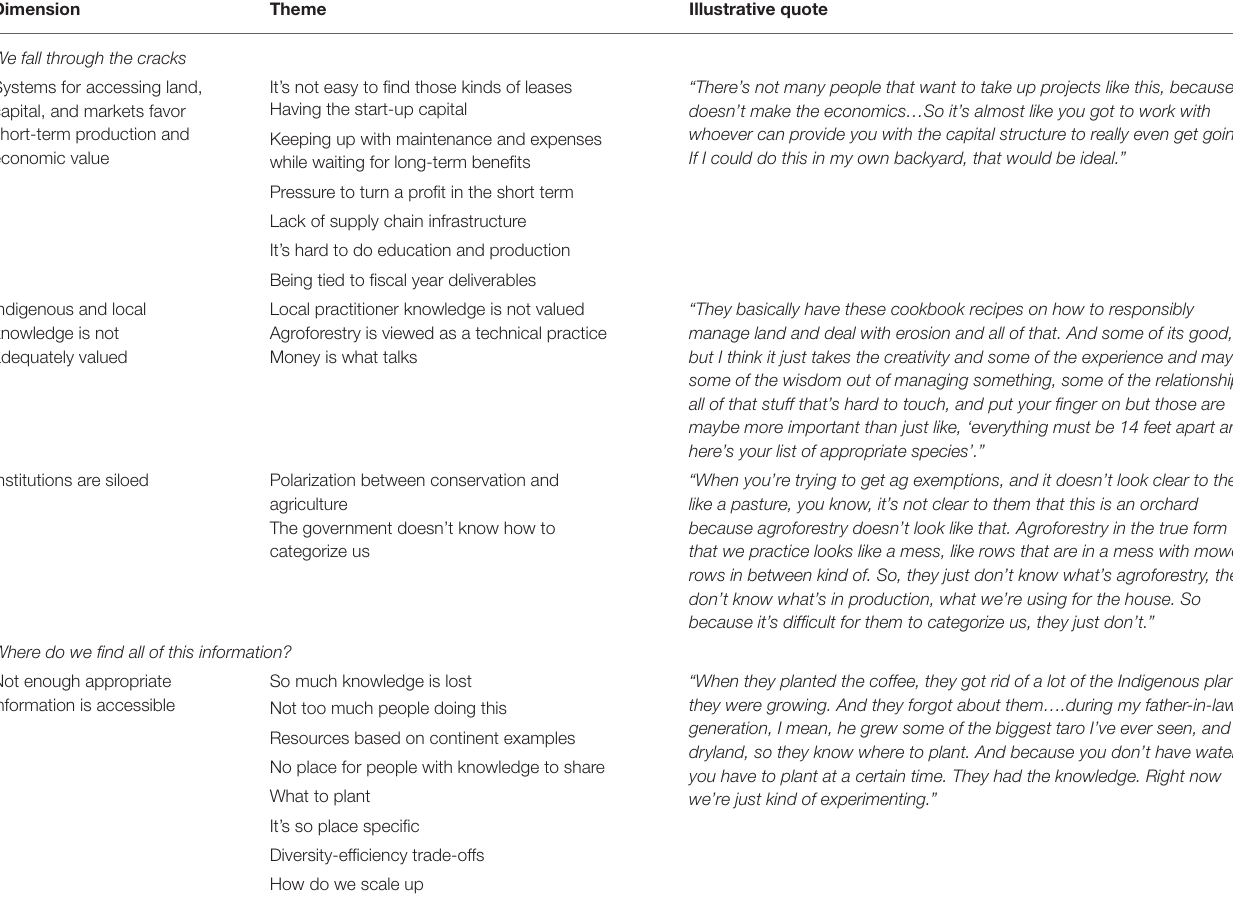
TABLE 2 | Obstacles specific to agroforestry that practitioners in Hawai‘i face.